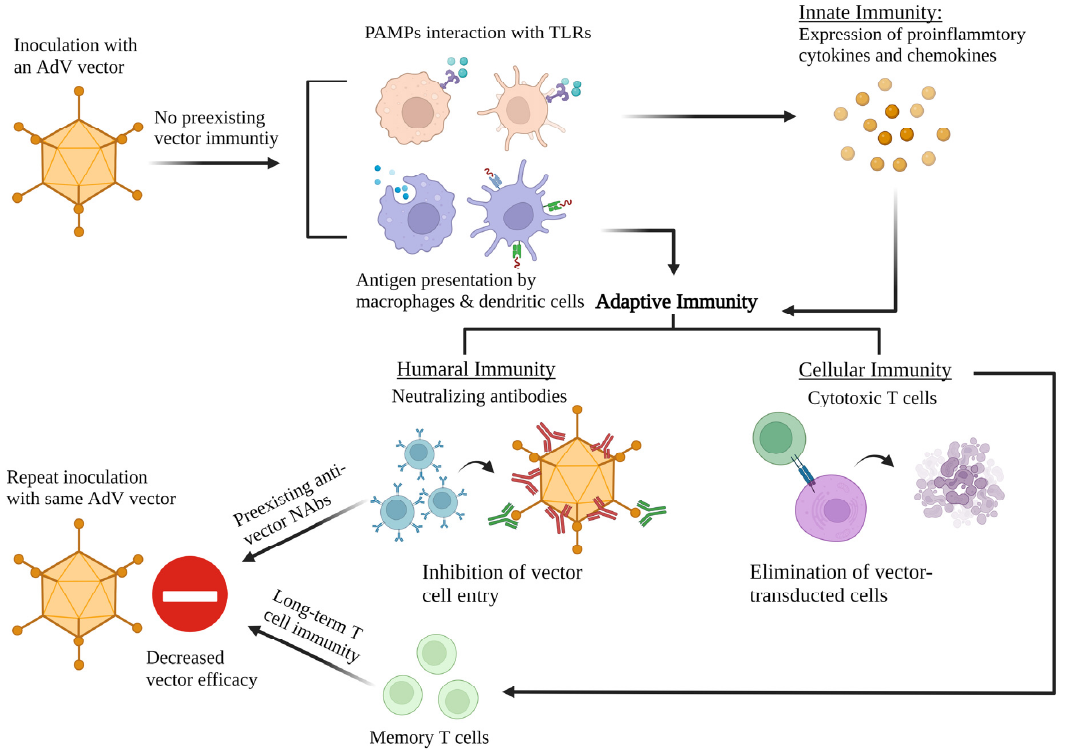
Figure 3. Activation of innate and adaptive immune responses in response to an adenoviral (AdV) vector. Following inoculation with an AdV vector, activation of innate immunity leads to the expression of proinflammatory chemokines and cytokines. Following antigen expression, processing, and presentation, humoral and cell-mediated immune responses develop. The resultant vector immunity will eliminate the vector, leading to a reduced duration of transgene expression. The development of vector-specific neutralizing antibodies (NAbs) and memory T cells provide long- term vector immunity and suppress subsequent inoculation with the same AdV vector. PAMP, pathogen-associated molecular patterns; TLRs, Toll-like